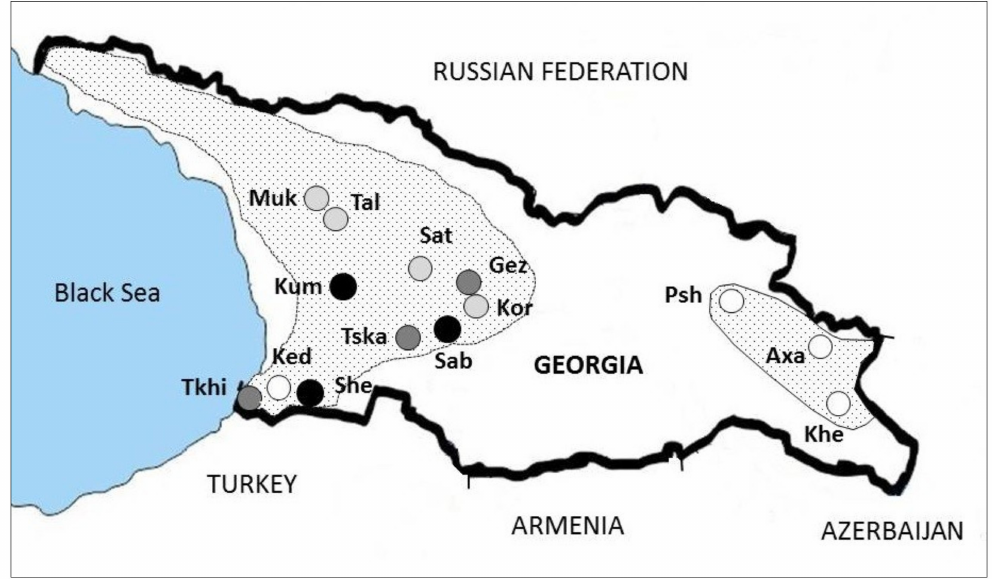
Figure 2. Prevalence and geographical distribution of CHV-1 in the C. parasitica populations in